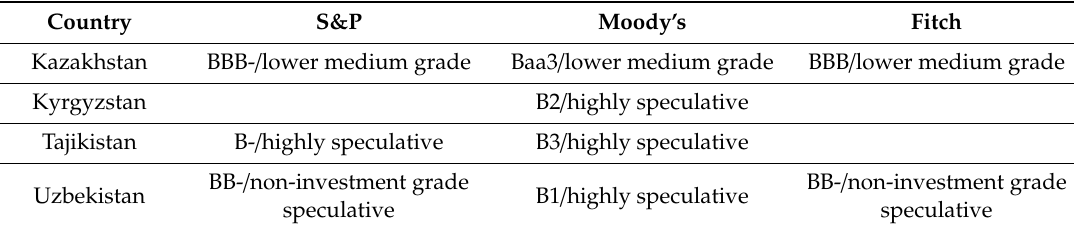
Table 12. Central Asian Economies’ Sovereign Debt Credit Ratings (Source: author based on Standard and Poor, Moody’s and